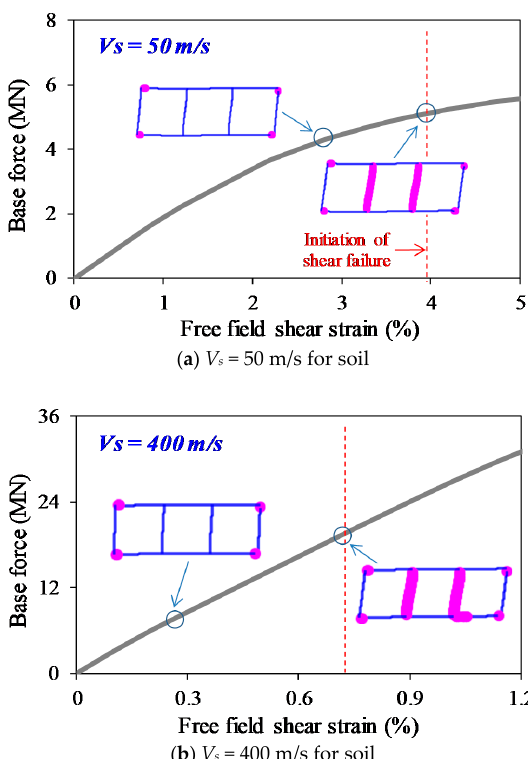
Figure 6. Development of plastic hinges for triple box with B/H = 1.0.